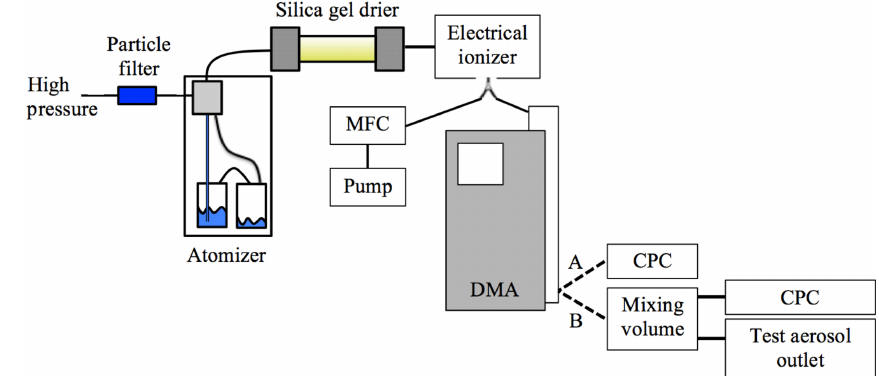
Figure 4. Experimental set-up for generating nigrosin aerosol. The dashed lines labelled A and B represent two independent flow lines (changed manually) used for scanning mode (line A) or fixed voltage size-selection mode (line B). Abbreviations: MFC is mass flow con- troller, DMA is differential mobility analyser and CPC is condensation particle